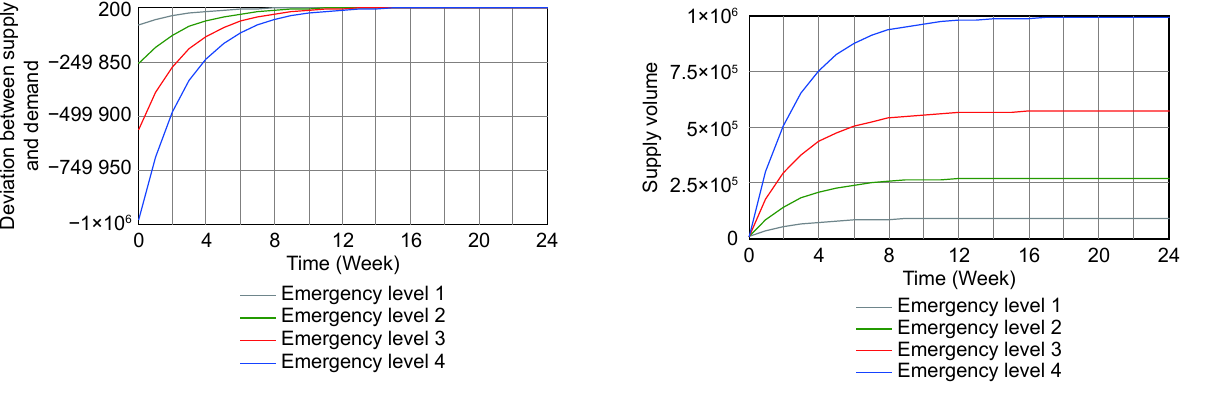
Fig. 8 Material supply quantity under different emergency